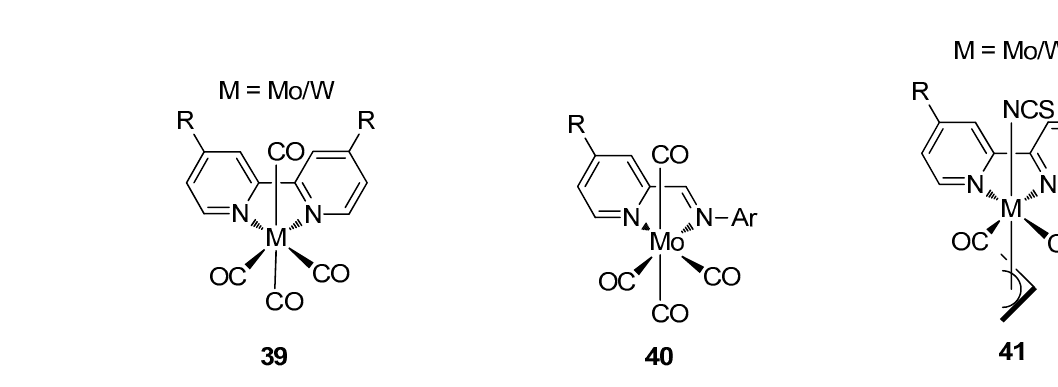
Scheme 12. Proposed mechanism of CO 2 electroreduction catalyzed by [Mo VI (O)S 2 (bdt) Cu I CN] 2 ‐